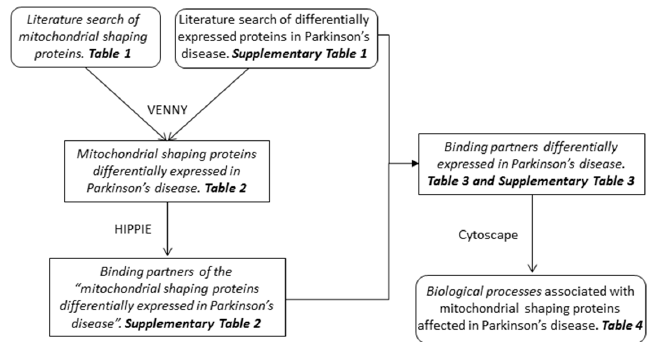
Figure 1. Flowchart showing the main steps used to identify the biological processes related to the mitochondrial-shaping proteins affected in Parkinson’s disease.